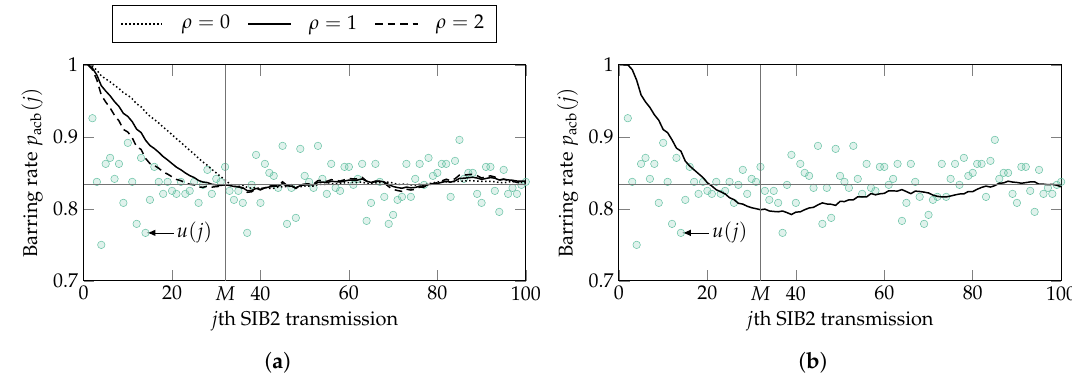
Figure 6. Ratio of idle to available resources u ( j ) and barring rate p acb ( j ) calculated at the j th SIB2 for a single simulation run and r = 54 under the traffic model 1 for the ( a ) LPF with ρ ∈ { 0,1, 2 } and ( b ) the LMS ALE algorithm. The horizontal line is located at E [ u ( j )]